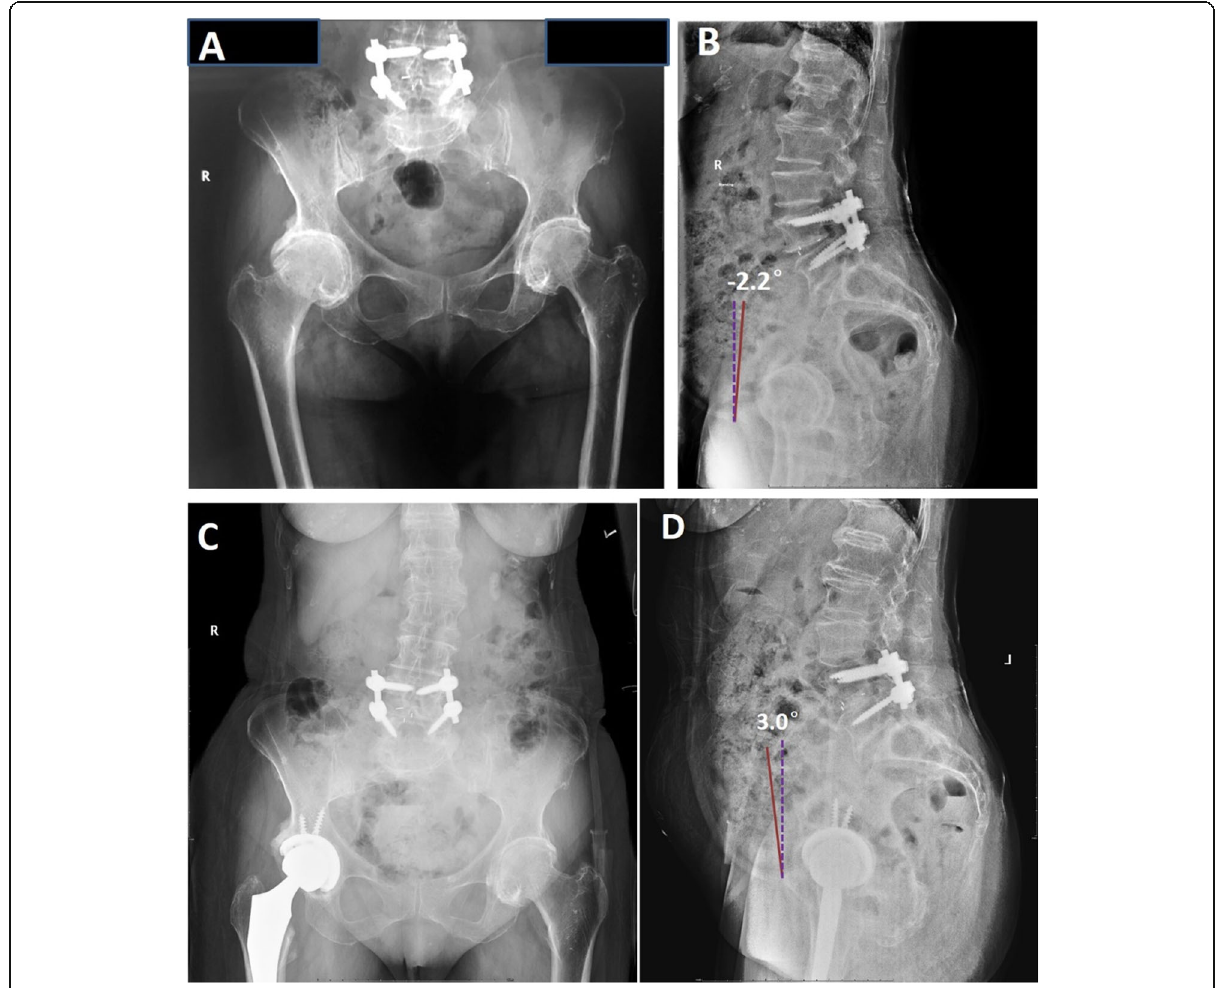
Fig. 5 A 72-year-old female underwent total hip arthroplasty with a prior lumbar fusion. The SPT before THA ( a , b ) and after THA ( c , d ) in the standing position was − 2.2 degrees (posterior SPT) and 3.0 degrees (anterior SPT),